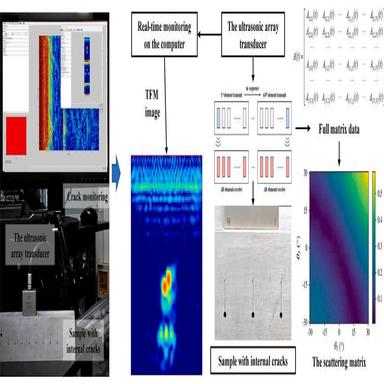
The experimental setup adopted for characterisation of crack-like defects.